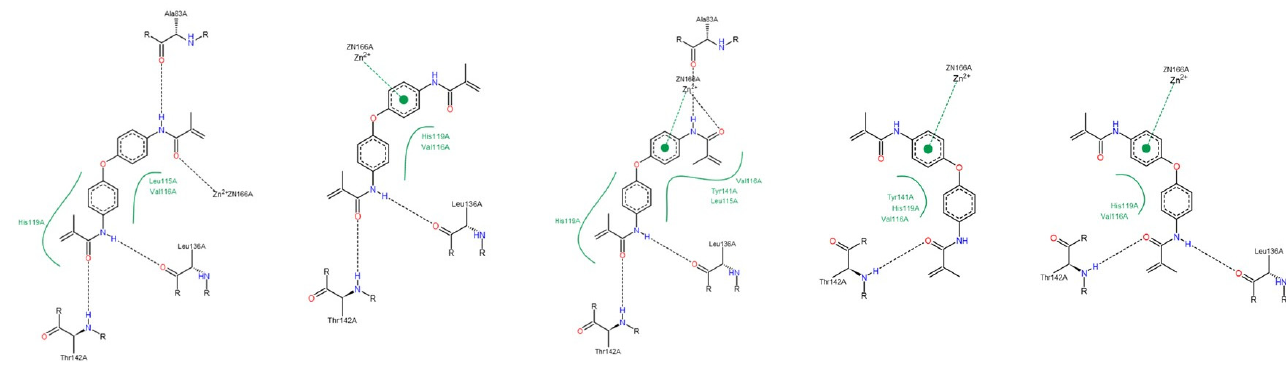
Figure A20. Interactions between compound C and MMP-13, by PoseView calculations.